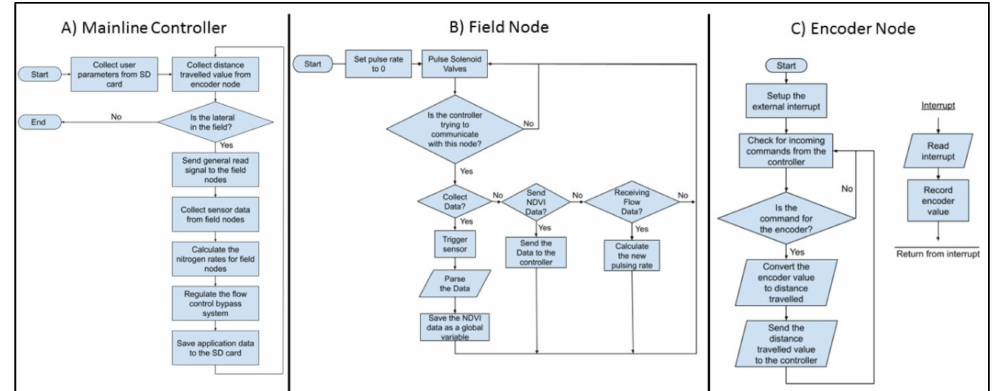
Figure 7. The program flow charts for the software written to wirelessly control the applicator system ( A ) the program flowchart for the mainline controller, ( B ) the program flow chart for the field nodes, and ( C ) the program flowchart for the encoder